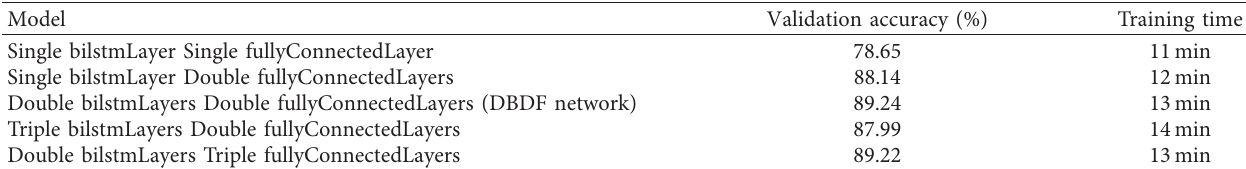
Table 6: Comparison of different classification networks without